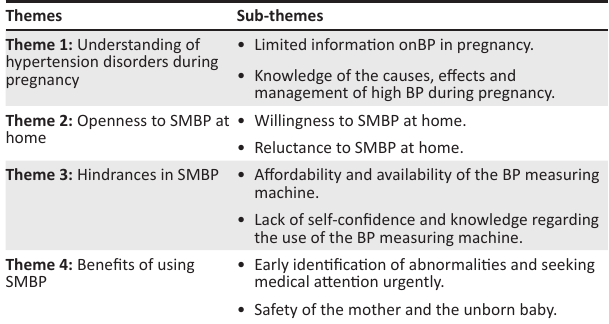
TABLE 1: Themes and